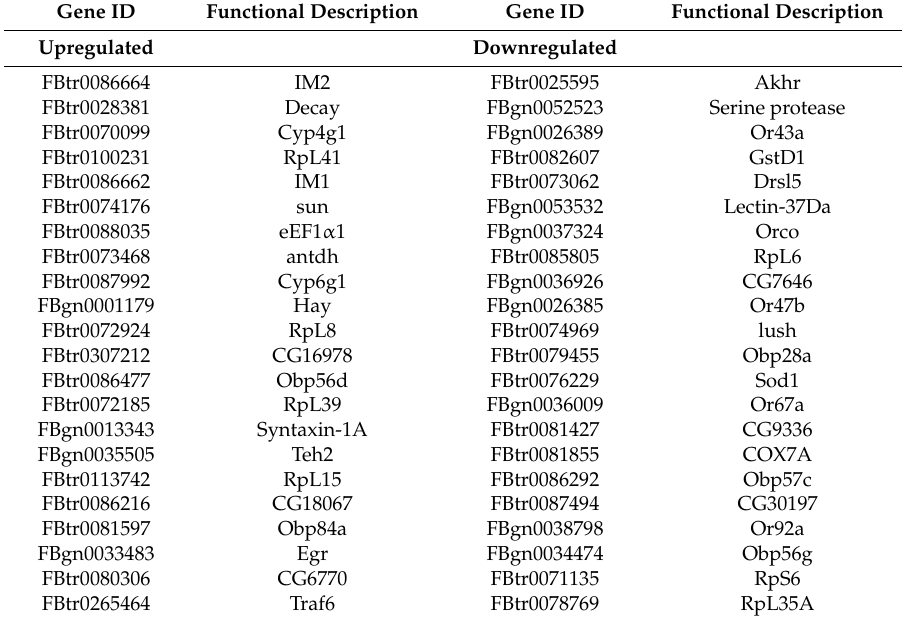
Figure 5. Gene expression changes in antennae of files on high fat diet. The x-axis is the − log10 p -value and the y axis is the fold-change value. Using the p -value 0.05 as the threshold cutoff, 97 genes in the left and right are selected. Red spots indicate the statistically significant differentially expressed genes (DEGs). Table 1. Functional description for differentially expressed genes.